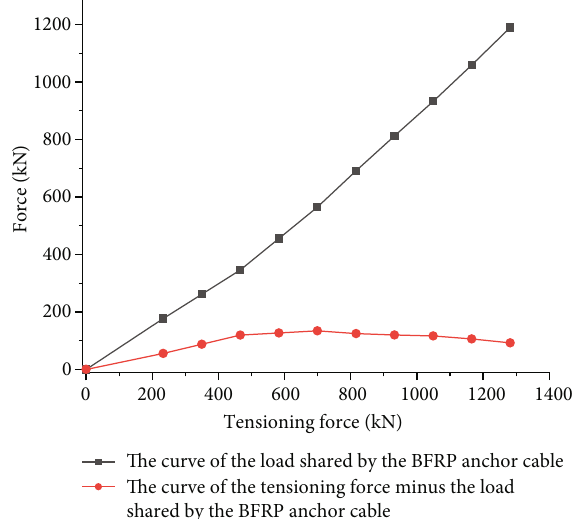
Figure 9: The load-bearing level by the large-tonnage BFRP anchor cable in the process of tensioning